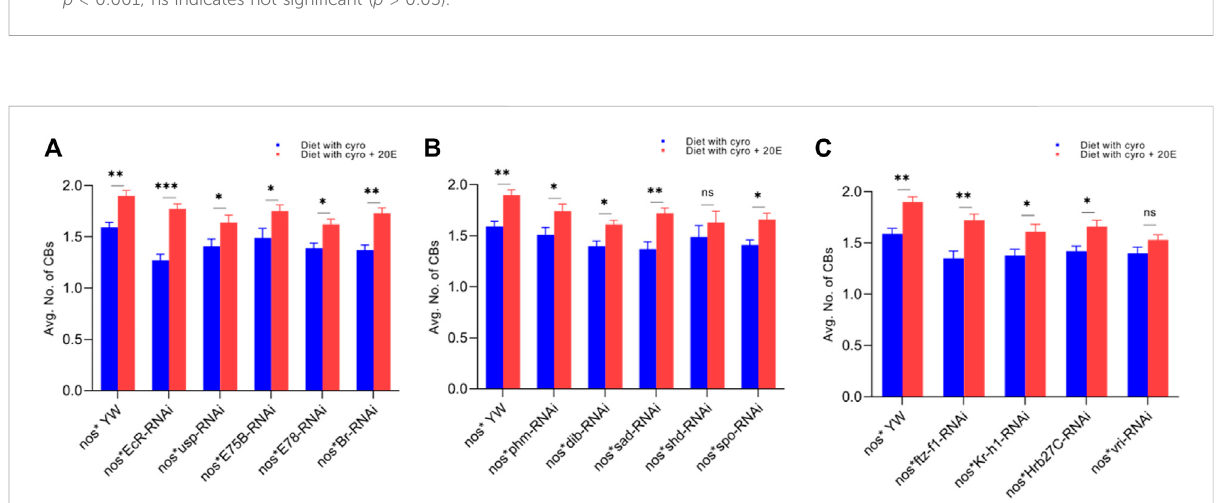
FIGURE 7 Rescue experiment of CBs. (A) The number of CBs against ecdysone-responsive primary genes. (B) The number of CBs against Halloween genes. (C) The number of CBs against ecdysone-responsive genes. The blue bars indicate the number of CBs against the cyromazine treatment, while the red bars indicate the number of CBs from the fl ies fed on a diet containing 20E with the cyromazine. For the t -test: * p < 0.05; ** p < 0.01; *** p < 0.001; ns indicates not signi fi cant ( p >